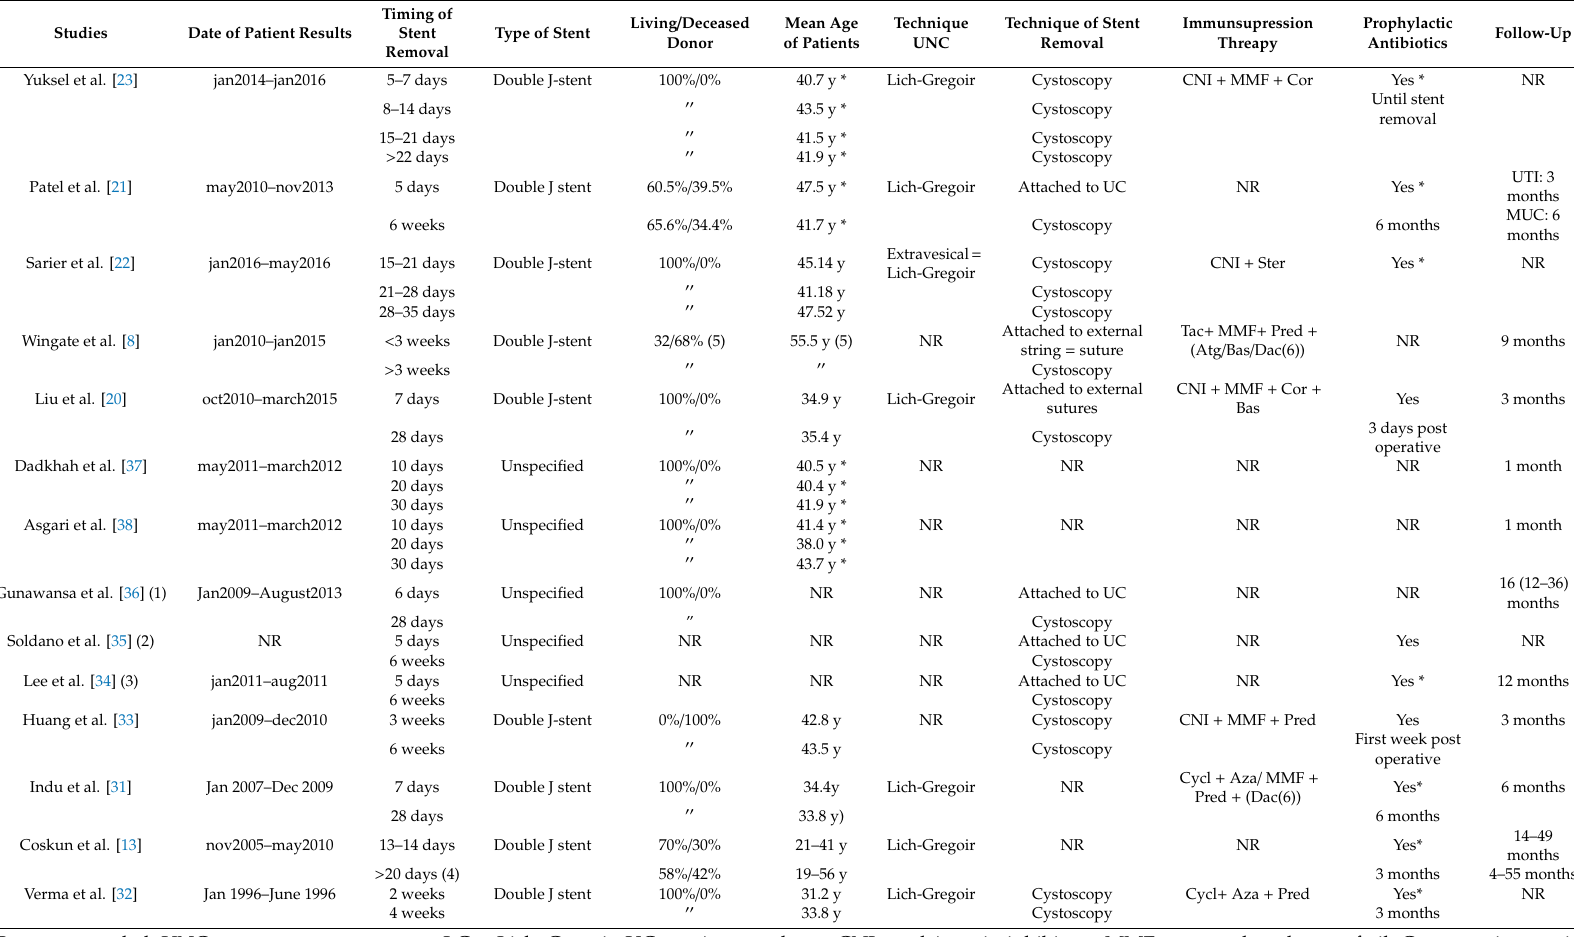
Table A1. Overview of the study